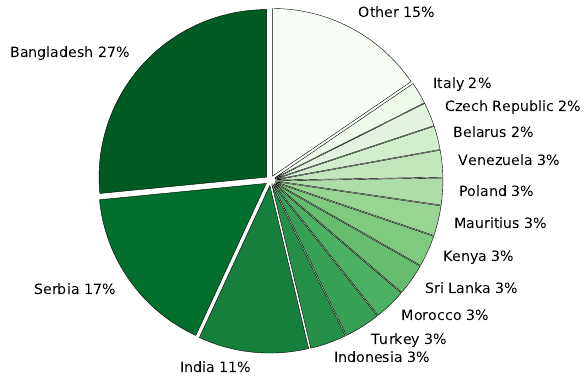
Figure 4. Countries of origin of all crowdworkers participating in our